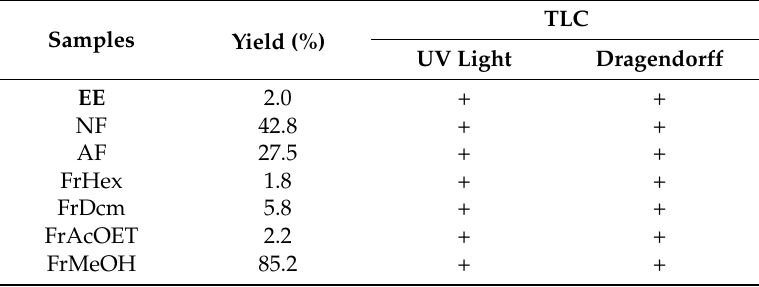
Table 1. Yields and thin layer chromatography of Geissospermum vellosii. TLC Samples Yield (%) UV Light Dragendorff